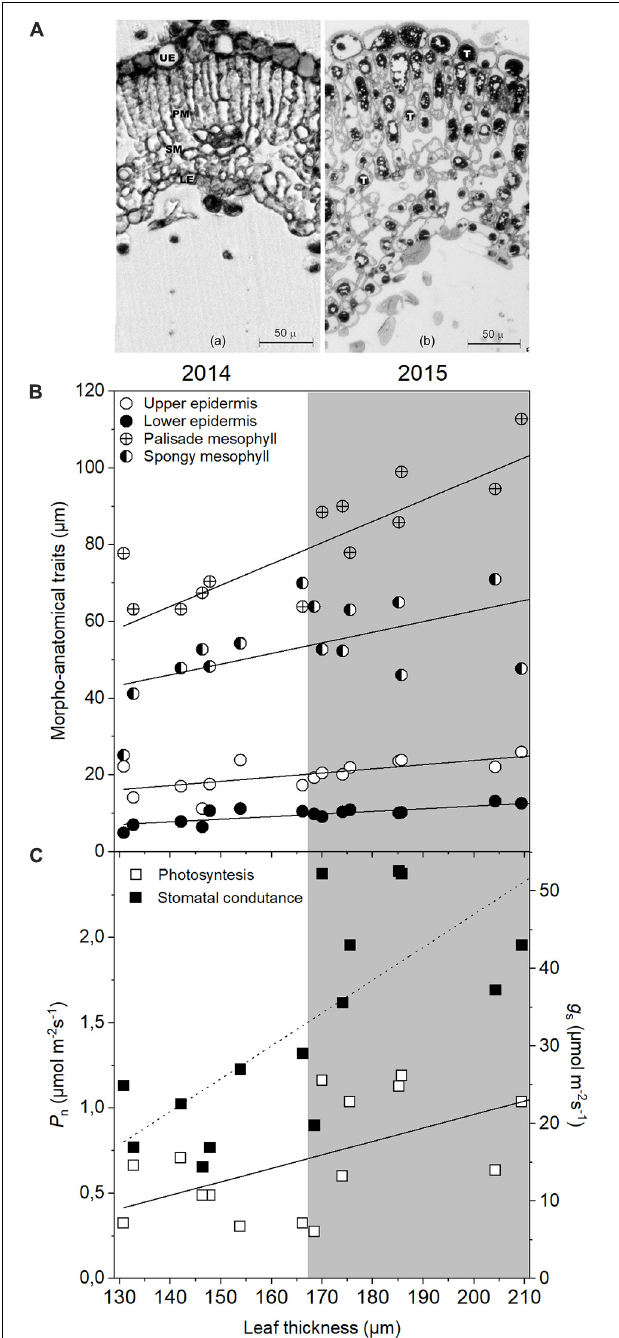
FIGURE 2 | Transverse cross sections of osmium-stained C. incanus leaves collected in July 2014 (a) and 2015 (b) illustrating the difference in in thickness of palisade parenchyma and epidermal cells between the plants collected in the two different years (A) . Condensed tannin deposits are shown in the vacuoles of cells. UE, upper epidermis; PM, palisade mesophyll; SM, spongy mesophyll; LE, lower epidermis; T, tannin. Bars = 50 µ m. Linear regressions between leaf thickness and the other morpho-anatomical traits (B) . Linear regressions between leaf thickness and photosynthesis ( P n ) and stomatal conductance ( g s ) (C) . Detailed analysis is presented in Supplementary Table S1 .